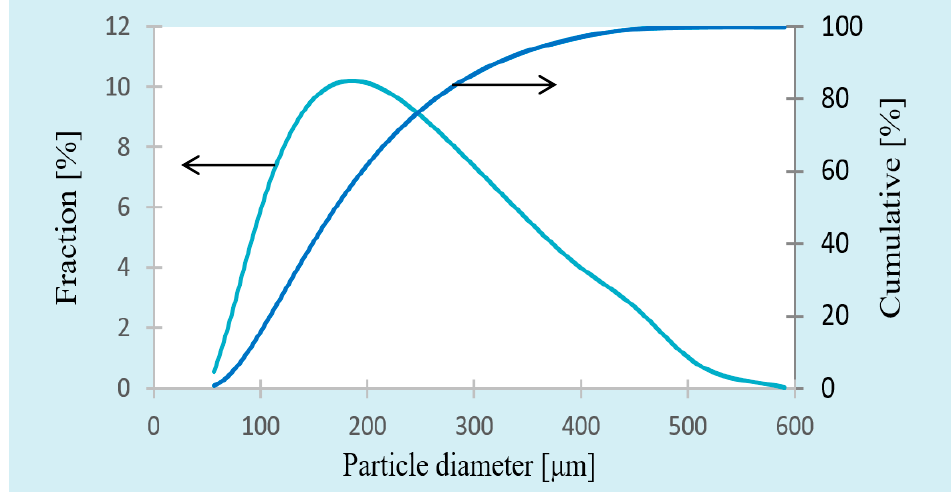
Figure 3. The particle size distribution of ilmenite.